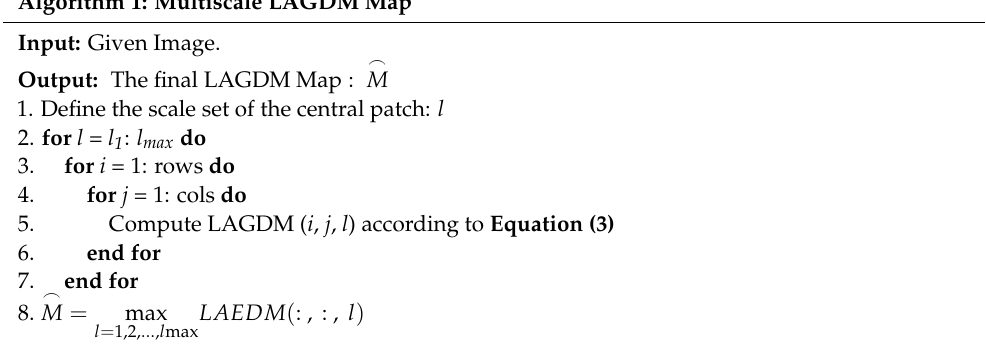
Algorithm 1: Multiscale LAGDM Map